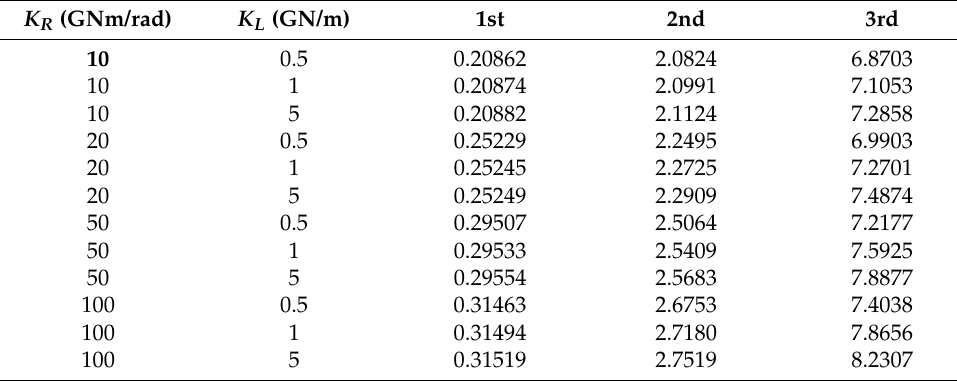
Table 1. The first three orders of the towers’ inherent frequency (unit: Hz). K R (GNm/rad)